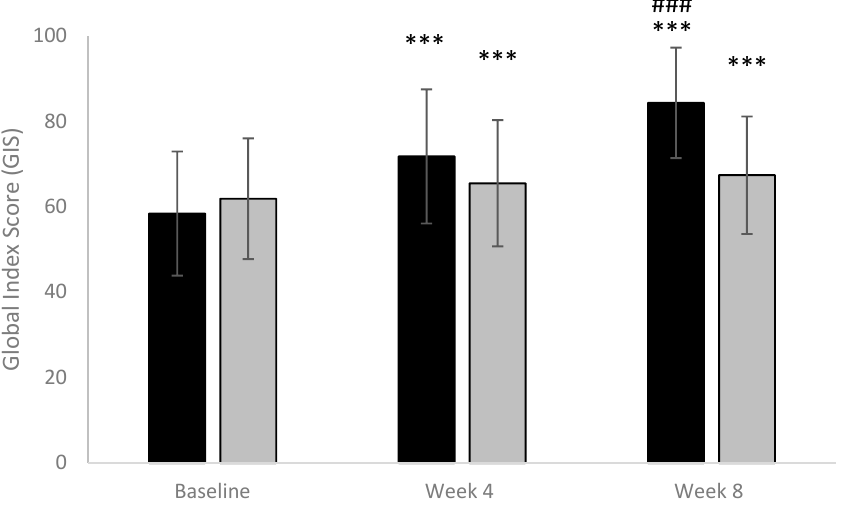
Figure 2. Global Index Score. (Black column: active; Grey column: placebo). *** p < 0.001 vs. baseline; ### p < 0.001 active vs. placebo.